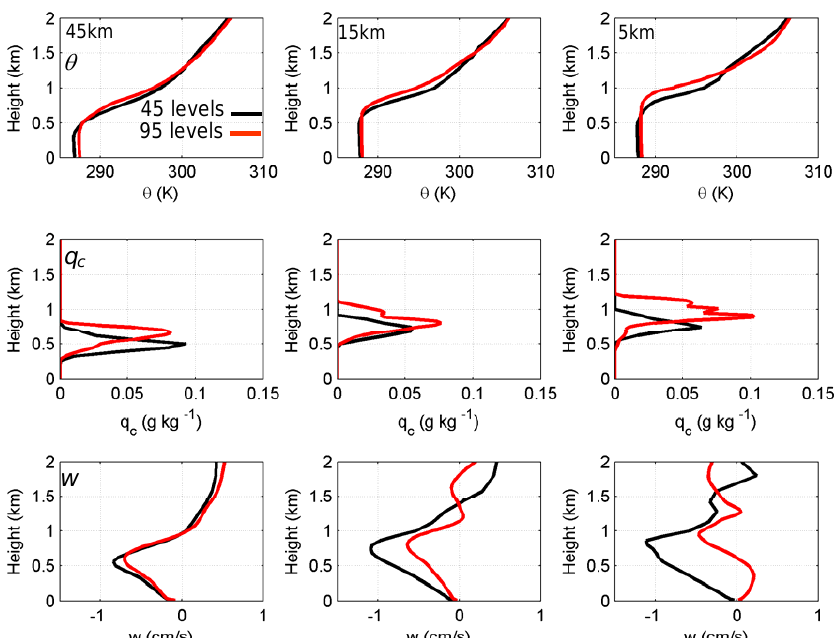
Fig. 16. Comparison of the 48 h-averaged MBL profiles between the control (45 levels) and the high-vertical resolution (95 levels) simulation at 72 ◦ W and 20 ◦ S. Upper panels: θ ; and middle panels: q c ; and the lower: w . The control forecast is denoted by black curves; and the high resolution by the red. The horizontal resolution is 45 km for the left panels, 15 km for the central, and 5 km for the right.